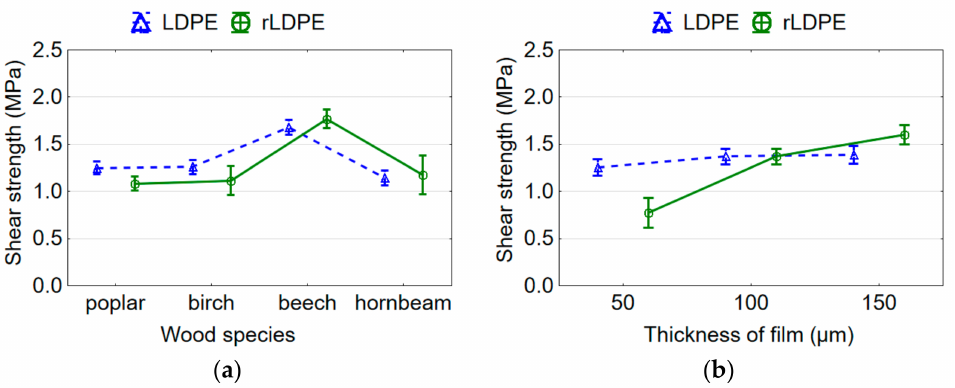
Figure 4. Mean plots of shear strength of plywood samples depending on type of adhesive, wood species ( a ) and thickness of rLDPE film ( b